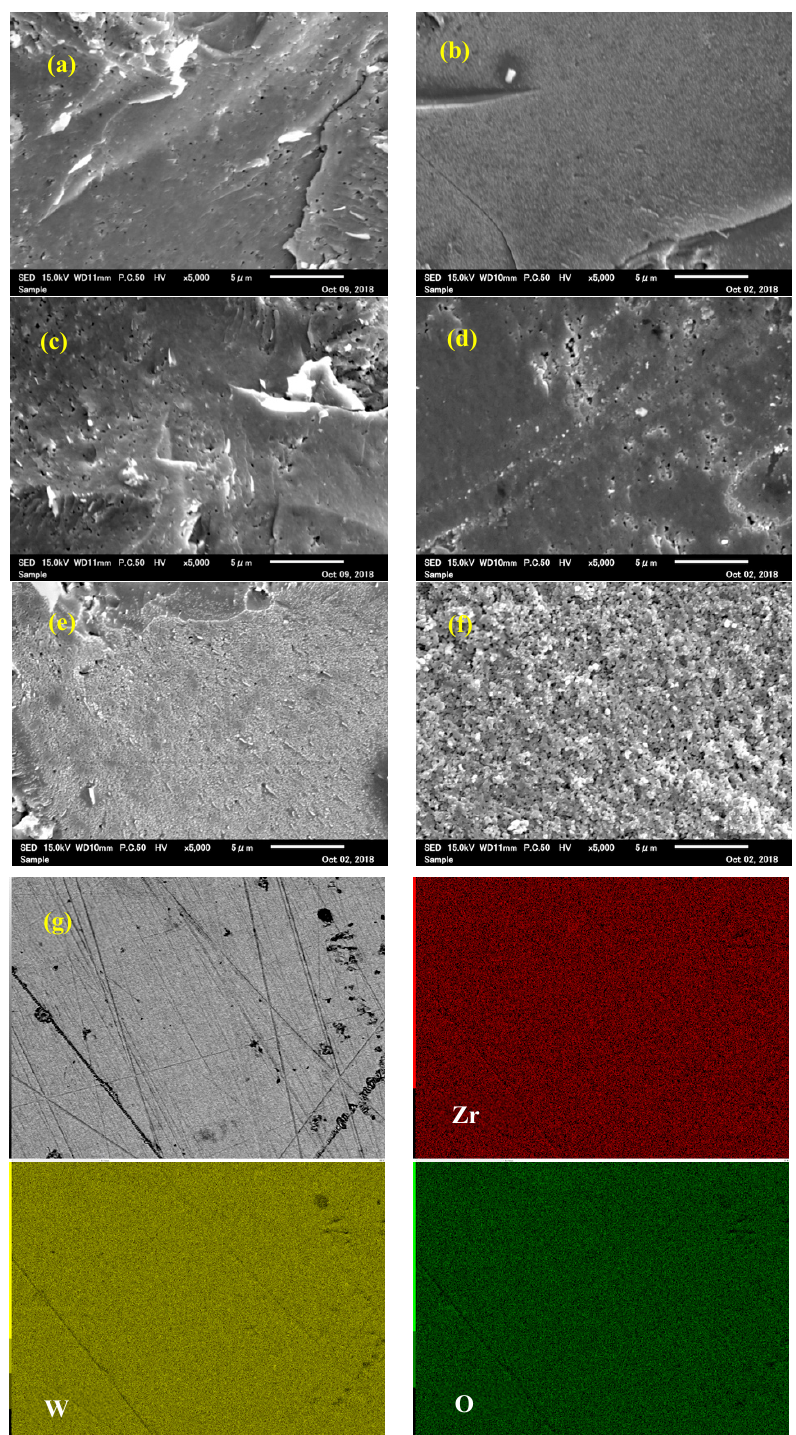
Figure 6. SEM micrographs of the fractured surface of cubic-ZrW 2 − x Mo x O 8 ceramics ( a ) x = 0.0 sintered at 923 K, ( b ) x = 0.0 sintered at 873 K, ( c ) x = 0.5 sintered at 873 K, ( d ) x = 1.0 sintered at 823 K, ( e ) x = 1.5 sintered at 743 K, ( f ) x = 2.0 sintered at 623 K, ( g ) SEM micrograph of the polished surface of cubic-ZrW 2 O 8 bulk ceramics with the corresponding EDS mapping of Zr, W, and O elements.